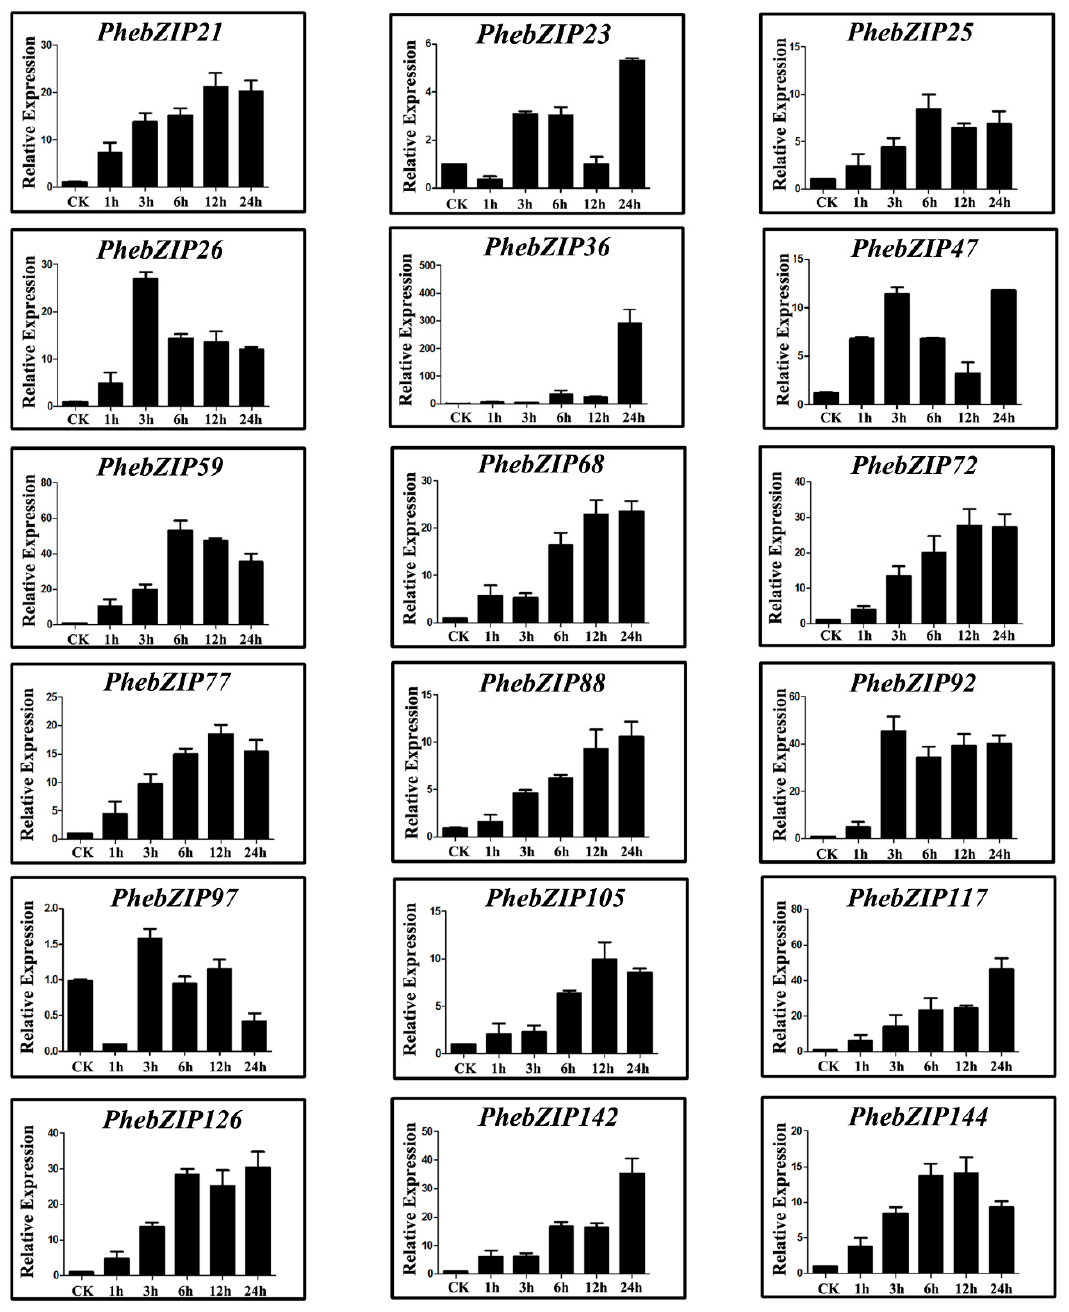
Figure 9. qRT-PCR expression analysis of selected PhebZIP genes following gibberellic acid (GA) treatment. The Y-axis indicates the relative expression levels; 0, 1, 3, 6, 9, 12, and 24 (X-axis) indicates hours of treatment. Mean values and standard deviations (SD) were obtained from three biological and three technical replicates.